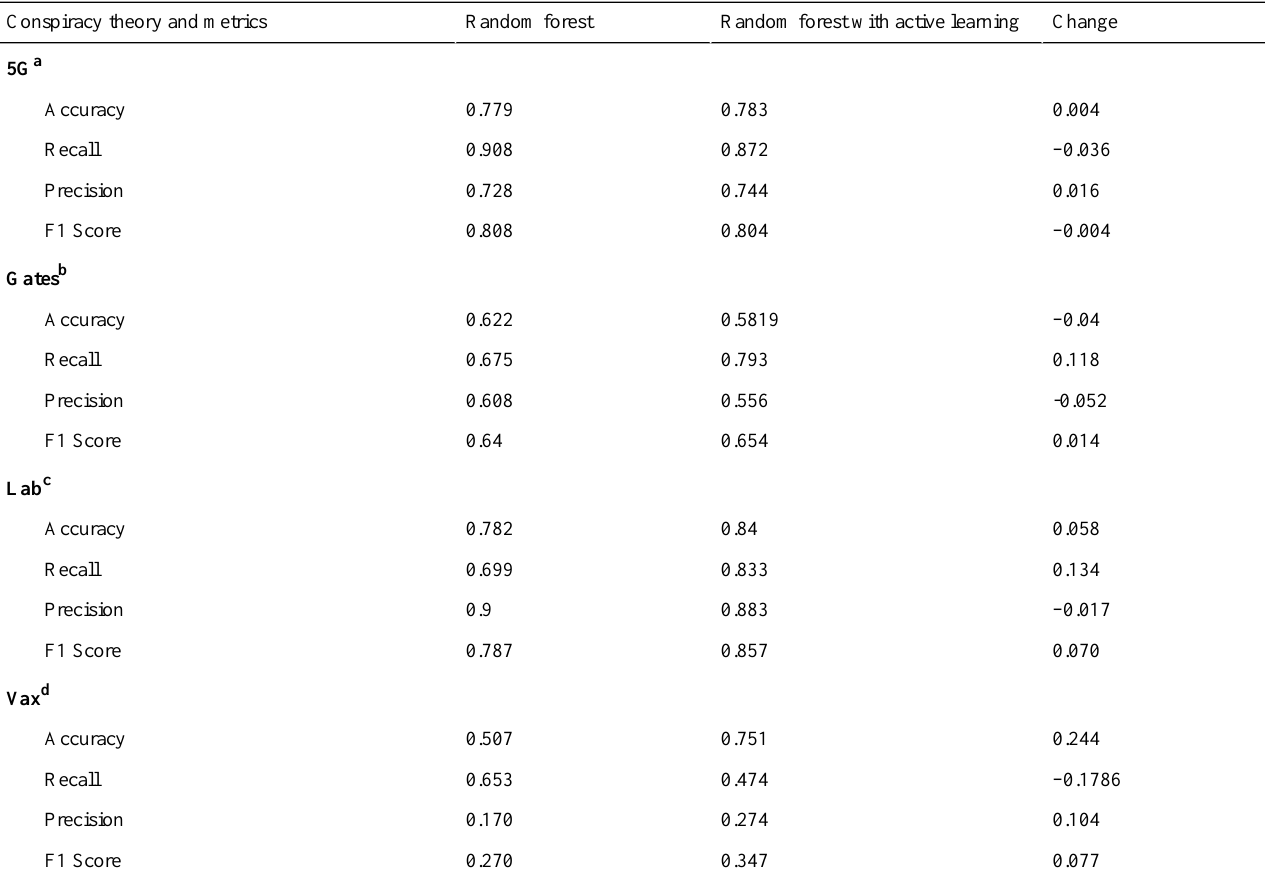
Table 4. Random forest model results. Random forest with active learning often, although not universally, shows improved performance compared to generic random forest models. The change between these two approaches is noted in the Change column.